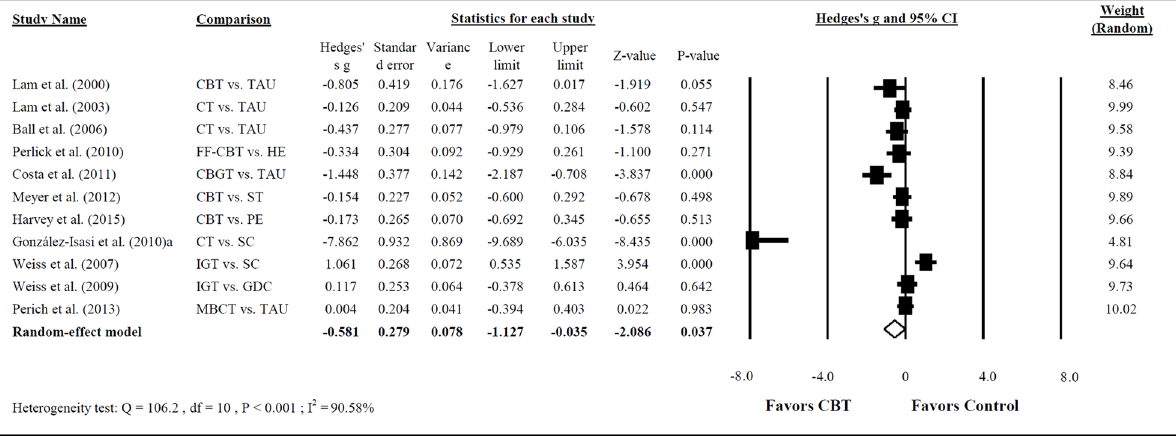
Fig 3. Forest plot of the meta-analysis for reducing mania severityin BD among patients treated with CBT compared with controls (n = 11 studies).